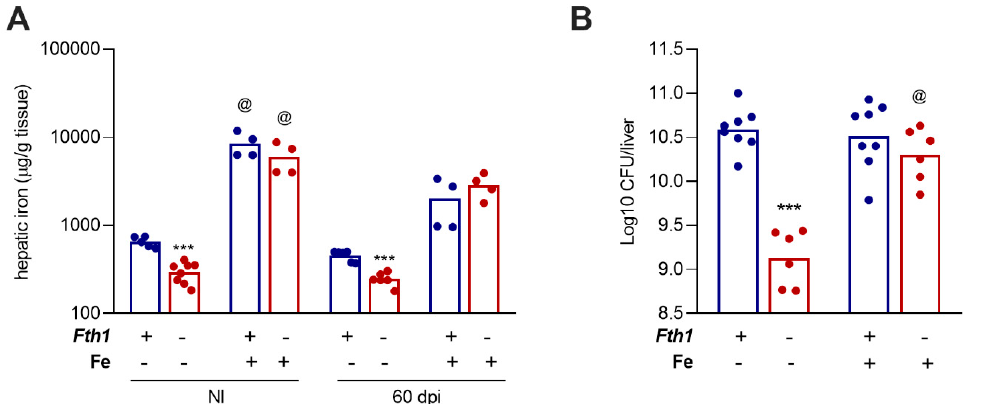
Figure 4. Effect of iron overload on the growth of M. avium in the liver. Groups of Fth1 +/+ (blue) and Fth1 − / − (red) mice were intraperitoneally injected with 10 mg of iron, in the form of iron–dextran, 10 days before intravenous infection with 10 6 CFU of M. avium 25291. Sixty days after infection, noninfected (NI) and infected (60 dpi) mice were euthanized. ( A ) Liver iron was quantified by atomic absorption spectrometry ( n = 4 to 8 per group). ( B ) Bacterial burden in the livers, 60 days after infection ( n = 6 to 8 per group). The bars represent the mean of the group, and each circle corresponds to one animal. Statistics: two-way ANOVA followed by Sidak multiple-comparison post hoc test. *** p < 0.001 when comparing Fth1 − / − to Fth1 +/+ mice in the same experimental condition. @ p < 0.001 when comparing iron-overloaded with non-iron-overloaded mice of the same genotype and infection status.